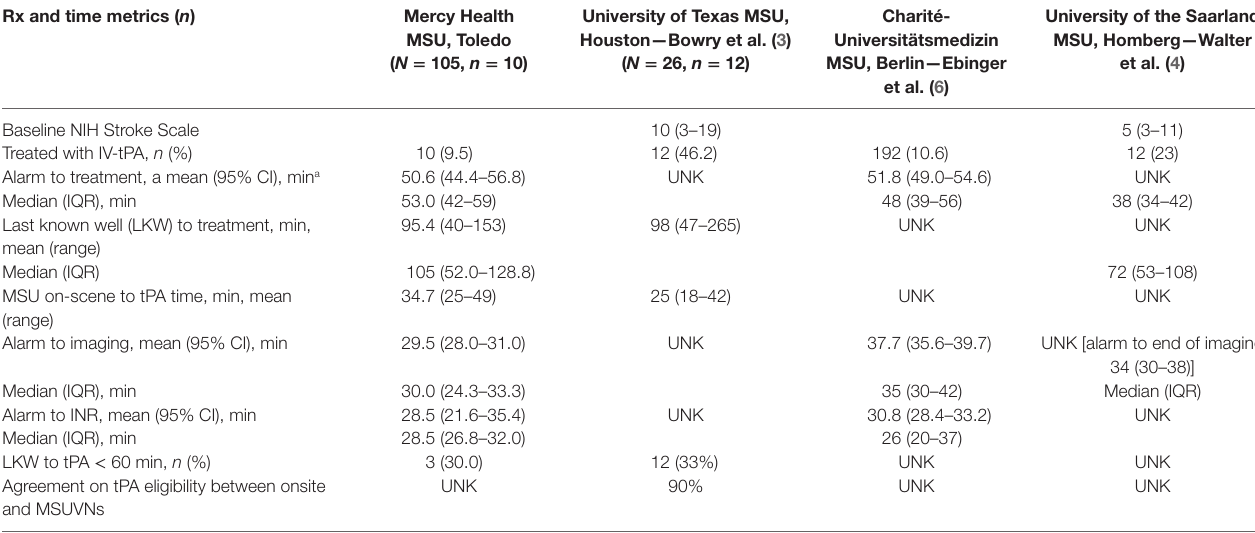
TaBle 2 | Time metrics and outcomes for Mercy Health Mobile Stroke Unit (MSU), Toledo. rx and time metrics ( n